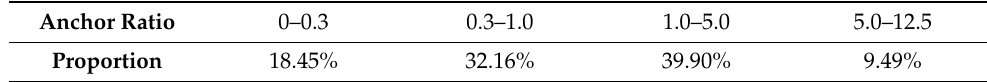
Table 3. Comparison of the results of different anchor ratio settings. Anchor